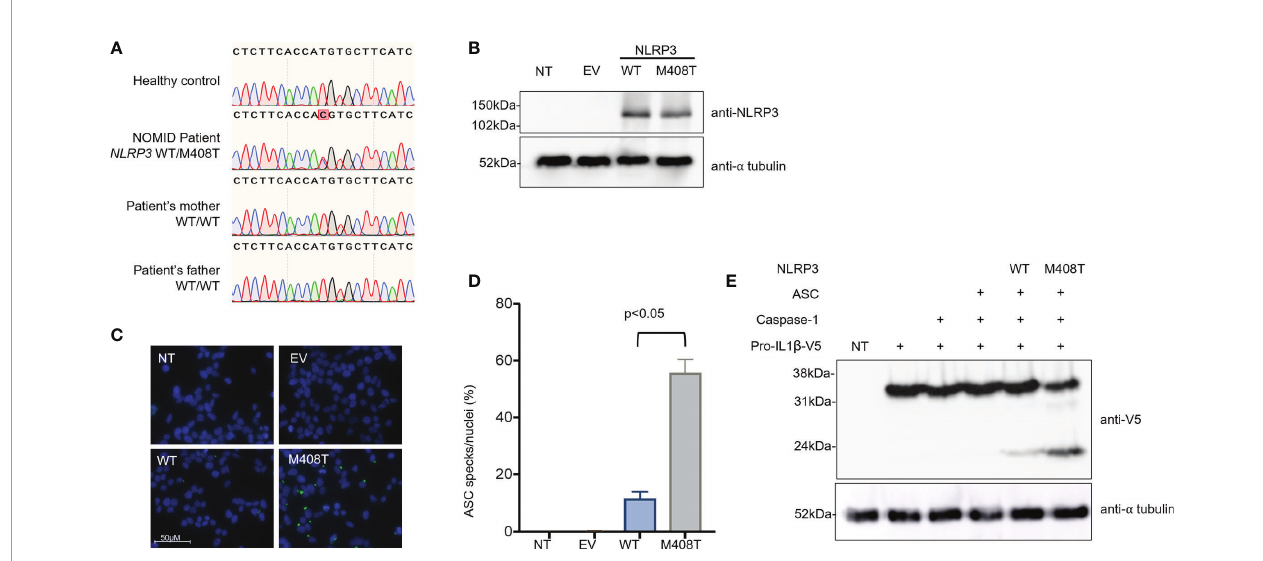
FIGURE 3 | The heterozygous denovoNLRP3 mutation M408T causes a gainoffunction for in fl ammasome activation. (A) GenomicDNA from a healthy control, the NOMID patient, and each ofhis parents was collected. PCR was used to amplify a region of NLRP3 surroundingthe patient ’ s mutation,and these PCR ampliconswere subjected to Sanger sequencing using a second set of speci fi c primers. A T>C singlenucleotide change, causingthe missense mutation M408T in NLRP3 protein,was con fi rmed to beheterozygousin the NOMID patient andabsent from each parent, indicating this isa denovo mutation. (B) Plasmidswere constructed, encodingan empty vector(EV),wild-typeNLRP3 (WT),or the NOMID patient ’ s NLRP3 mutation (M408T). HEK293T cells were either leftnon-transfected(NT)orwere transfected with these plasmids, and wholecelllysates were used for westernblotting. Using an antibody speci fi c for NLRP3, expression of both WTand M408T NLRP3 protein was observed at the expected size (118kDa) with nonotable difference in expression resulting from the mutation. Alpha-tubulin isusedas a protein loading control. (C) HEK293 ASC-YFP cells were plated on coverslips, then were either leftnon-transfected (NT),ortransfected with an empty vector (EV) or plasmidsencoding WTor M408T NLRP3. Cells were stained with DAPI, mountedand visualized by fl uorescence microscopy. Images are representative of 8 or more fi elds per condition. (D) Summary of ASC specksper nuclei for the experiment presented in (C) , andreplicate experiments (n=4).P value isfrom a Mann-Whitney t-test. (E) HEK293T cells were either leftnon-transfected (NT, lane 1) or were transfected with the indicated combinationsof plasmidsencoding pro-IL-1 b -V5, Caspase-1, ASC, and WTorM408T versionsof NLRP3. After 8 hours, whole celllysate was prepared andusedfor westernblotting. Pro-IL1 b isexpectedto migrate at 35.8kDa, whilethe mature cleaved formofIL-1 b